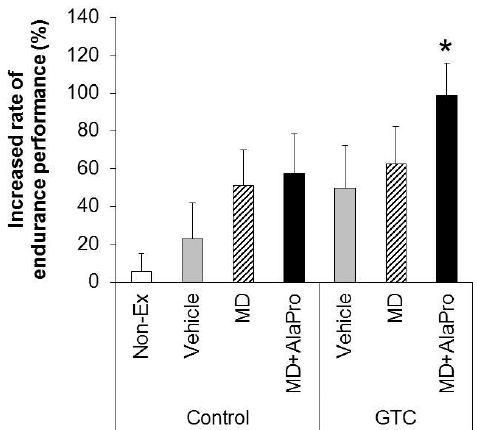
Table 2. Body and tissue weights.